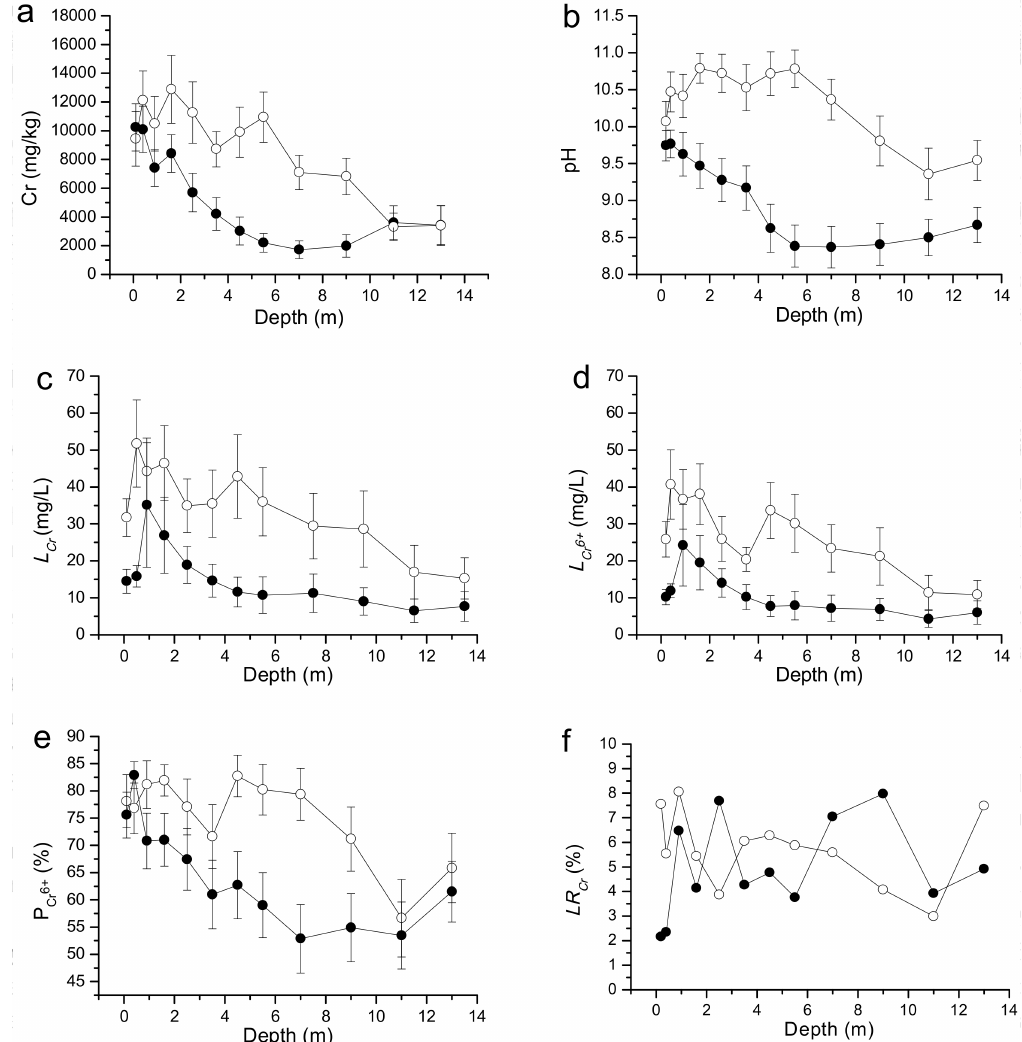
Figure 3. The Cr concentration ( a ), pH ( b ), L Cr ( c ), L Cr 6+ ( d ), LR Cr ( e ) and P Cr6+ ( f ) of soil profiles that obey binomial distribution changes with depth in the chromate production sites (CPS). Solid Circle: soil profiles obey a Positive Binomial Distribution ( n = 29); Open Circle: soil profiles obey a Negative Binomial Distribution ( n =